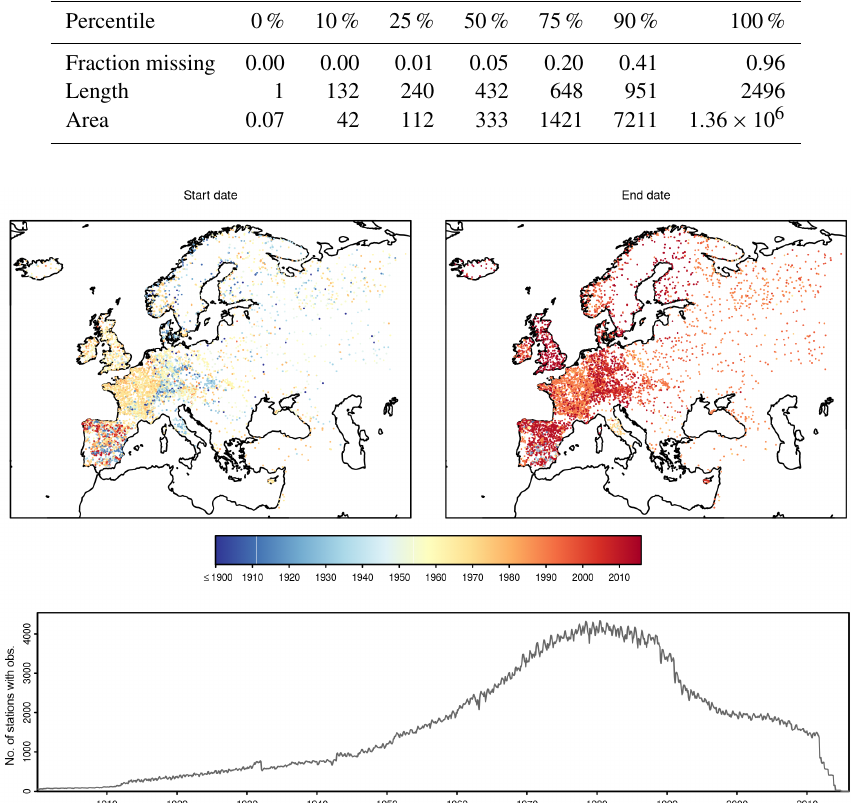
Figure 2. Spatial and temporal coverage of available streamflow observations. The top row shows the date of the first and the date of the last available observation at each station. The bottom panel shows the total number of stations with observations for each